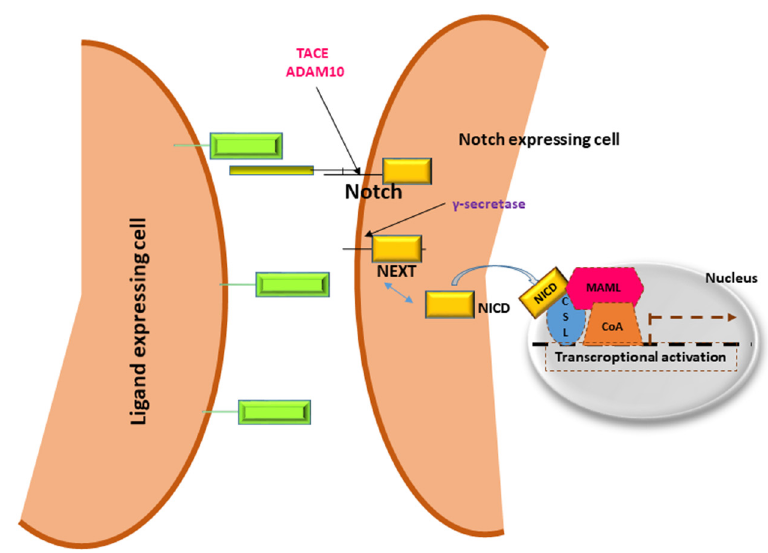
Figure 1. Notch signaling pathway.